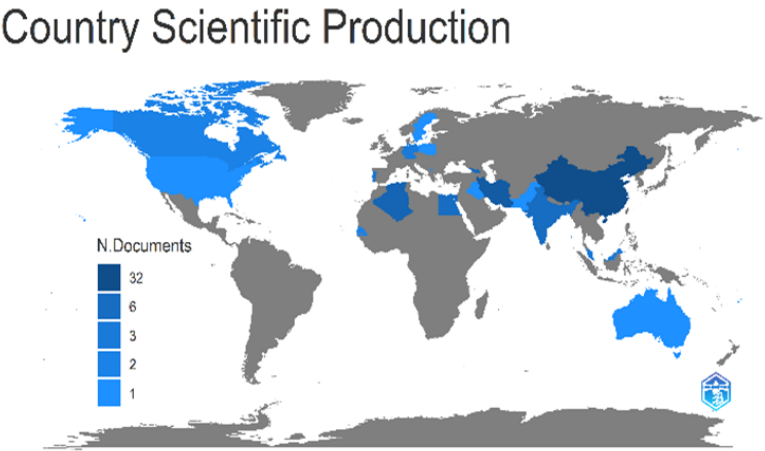
Figure 3. A graphic map of OBH models to predict ETo time series.